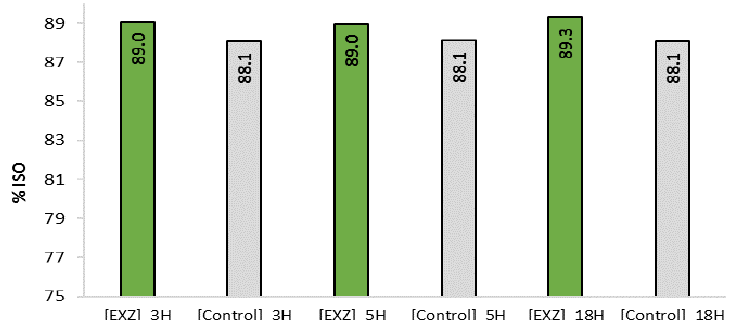
Figure 1. Scheme of the typical production process of a bleached kraft pulp (grey) with enzymatic treatment, EXZ stage (green), applied after the O 2 delignification stage.